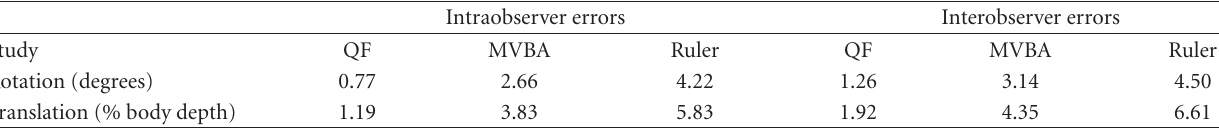
Figure 8: User interface image showing graphical and numerical output of overall IAR position and as the location of this position on the image. Table 2: Observer repeatability for three measurement methods (mean